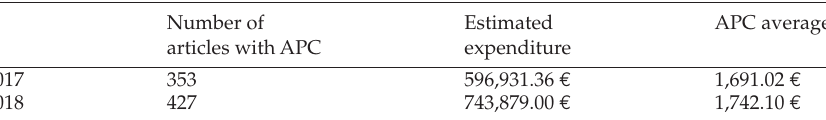
Table 7: Estimated expenditure on APC from the UB for 353 articles in 2017 and 427 articles in